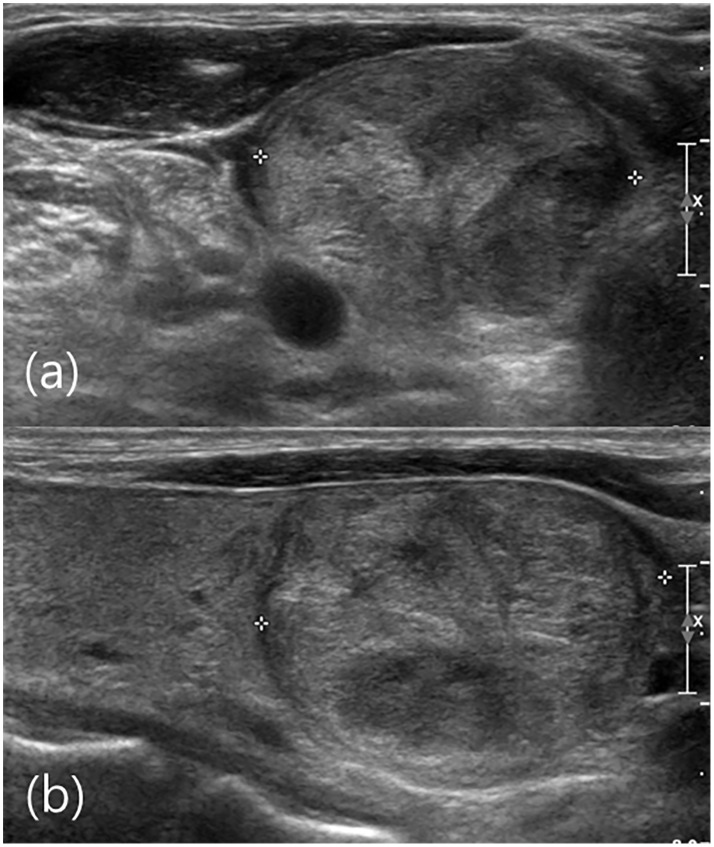
US image of right thyroid gland of a 51-year-old male.(a) Axial view show a circumscribed isoechoic nodule (crosses). (b) Sagittal view a 2.9 cm circumscribed isoechoic nodule (crosses) is visible in the lower portion of the right thyroid gland. The US diagnosis was probably benign and the FNA result was Bethesda category IV (follicular neoplasm). Follicular thyroid carcinoma was revealed by total thyroidectomy. US was not informative for this Bethesda category IV nodule.